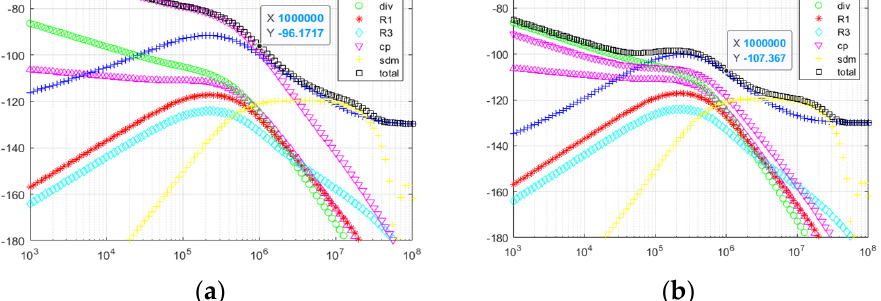
Figure 10. Optimization result compared to a conventional flow on overall PLL: ( a ) manual optimization with limited iterations; ( b ) proposed optimization with more layout-free design iterations. Electronics 2023 , 12 , x FOR PEER REVIEW